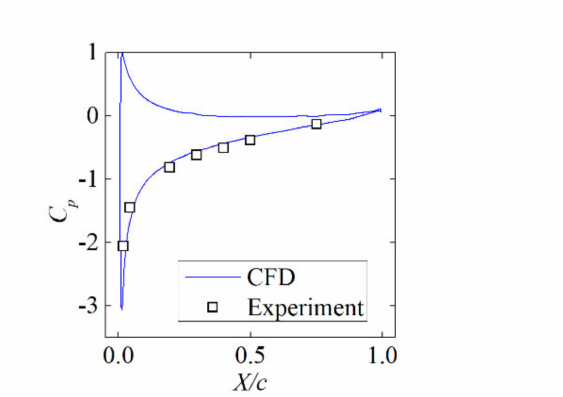
Figure 3. Verification of the CFD prediction on pressure coefficient C p based on the experimental data [12,34].